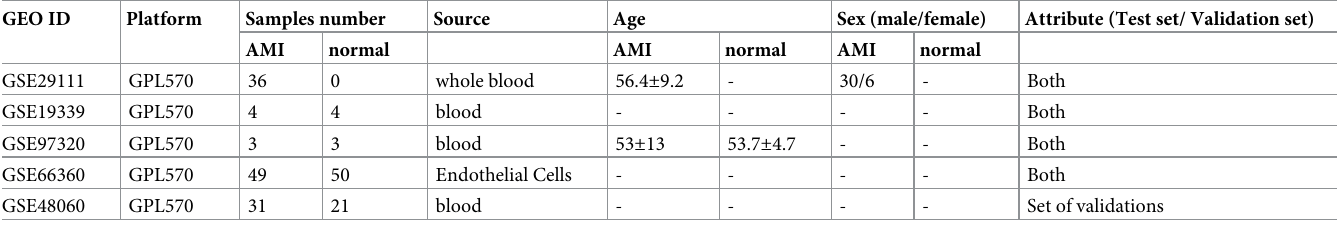
Table 1. Data set information